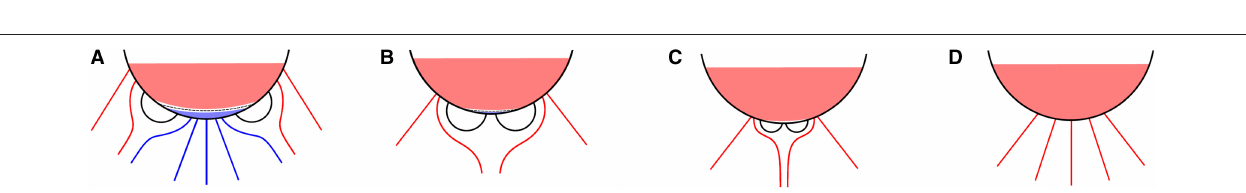
FIGURE 2 | Schematic view of streamer to pseudostreamer transition (A,B), followed by the shrinking of the pseudostreamer (C) until its complete disappearance (D). The polarity inversion line is indicated by the dashed black line; domains of opposite polarity are denoted by the open red and blue field lines; closed lines are in